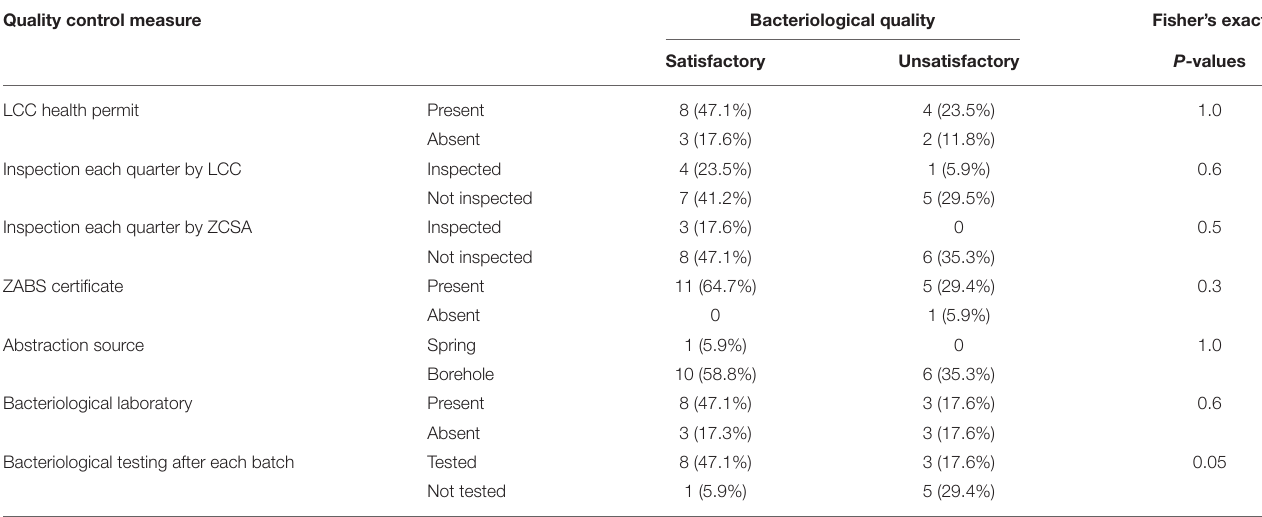
TABLE 5 | Quality control measures associated with bacteriological